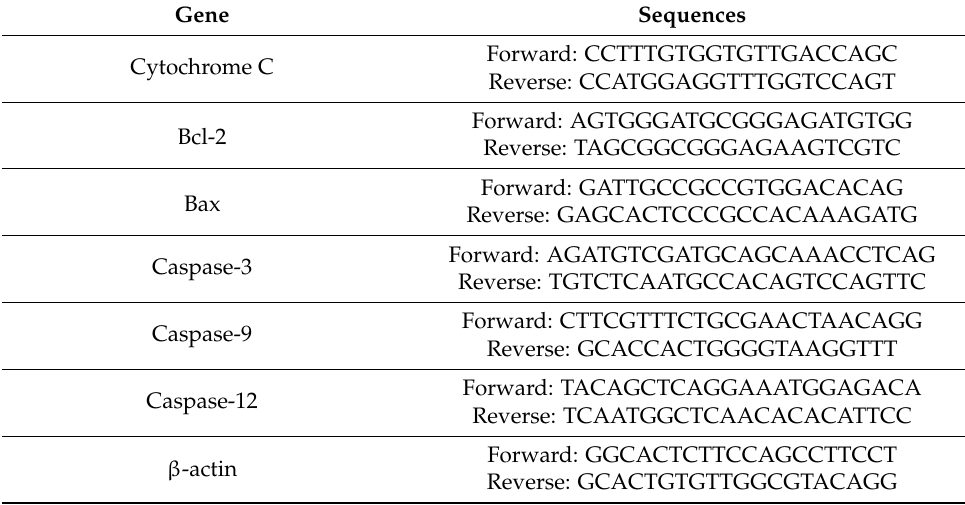
Table 1. Primer sequences used for RT-PCR (5 (cid:48) -3 (cid:48) ). Gene